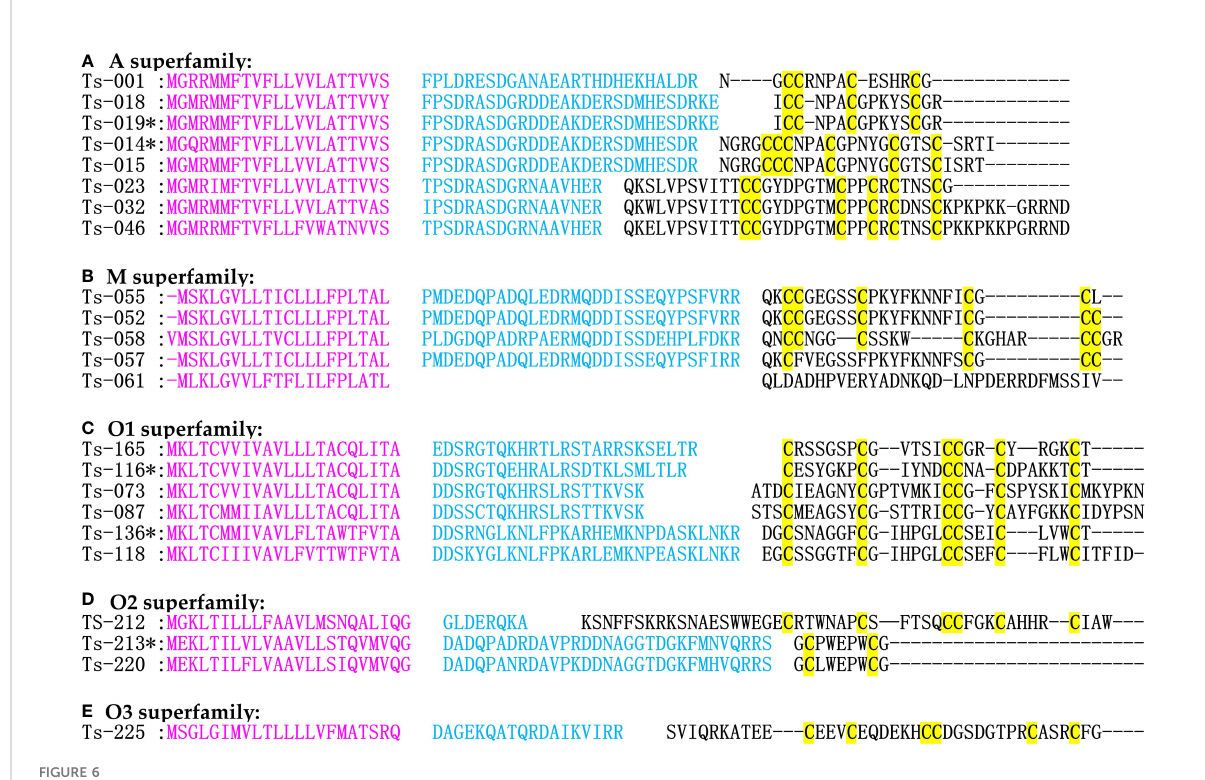
FIGURE 6 Alignment of the achieved A, M and O superfamilies sequences from our C. striatus transcriptomes. Stars (*) represent those conotoxins reported previously. Signal regions (in pink), pro-peptide regions (blue), mature regions (black), and cysteine residues (in yellow) are marked for